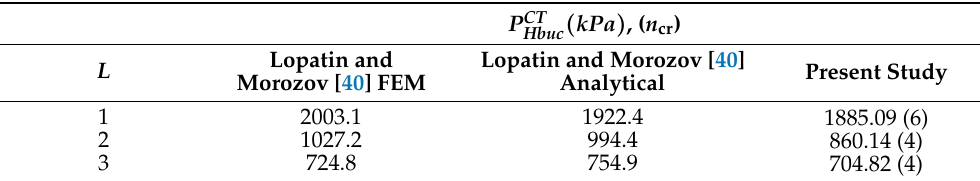
( kPa ) for single-layer cylindrical shells made of homogeneous material Table 2. Comparison of P CT Hbuc with clamped edges.